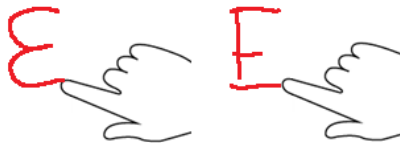
Figure 1 . Types of stroke-based gestures: single-stroke (left), multi-stroke